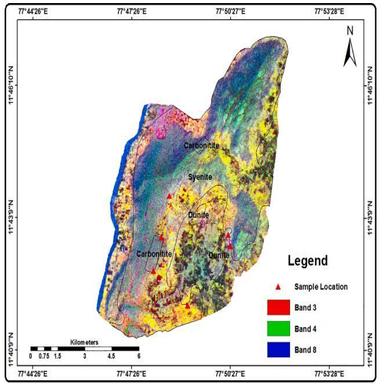
Principal Component Analysis image of Pakkanadu Carbonatite Complexes generate using ASTER band 3, 4, 8 in RGB and the carbonatite in green color, syenite in blue color and dunite in violet color.